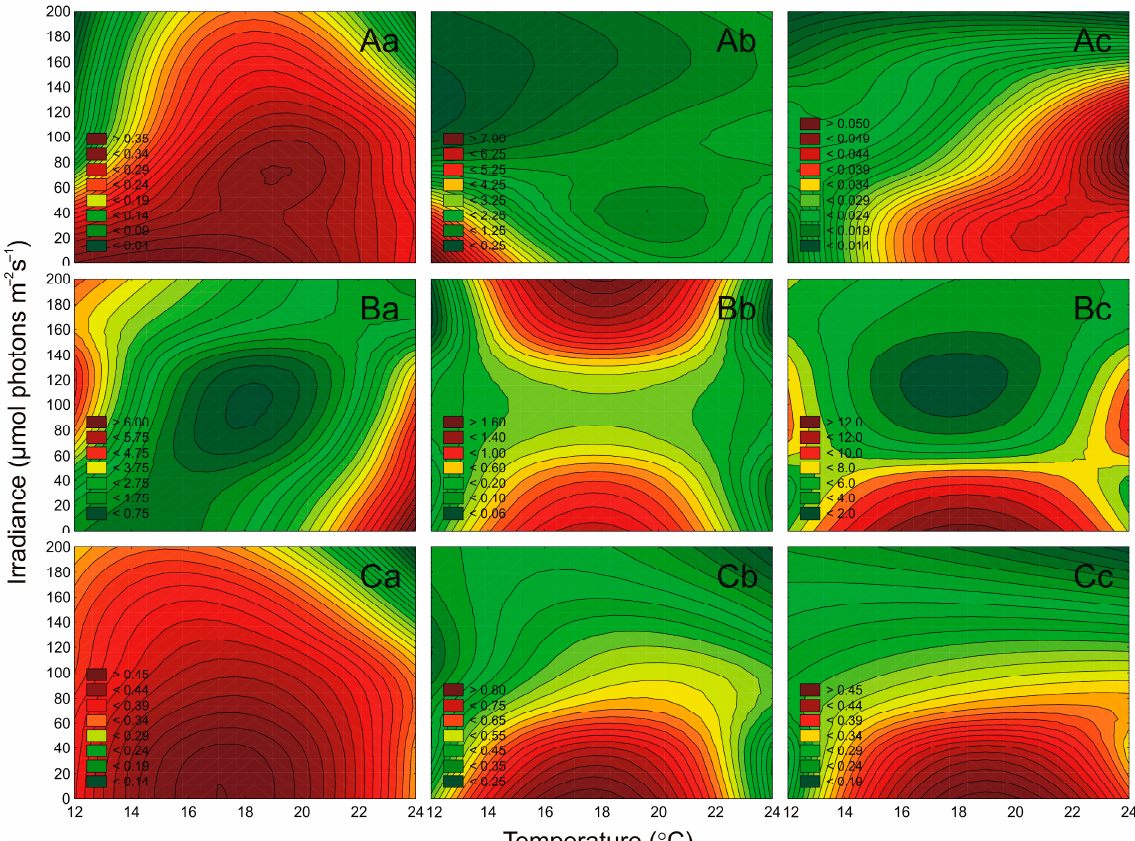
Figure 5. Changes in Chl a content (pg cell –1 ) obtained after 7 days of experiment for airborne cyanobacteria: Nostoc sp. (Aa), Synechococcus sp. ( Ab ), and Aphanothece sp. ( Ac ); airborne green algae: Oocystis sp. ( Ba ), Coccomyxa sp. ( Bb ), and Kirchneriella sp. ( Bc ); airborne diatoms: Nitzschia sp. ( Ca ), Amphora sp. ( Cb ), and Halamphora sp. ( Cc ) under different irradiance (µmol photons m –2 s –1 ) and temperature (°C) conditions.